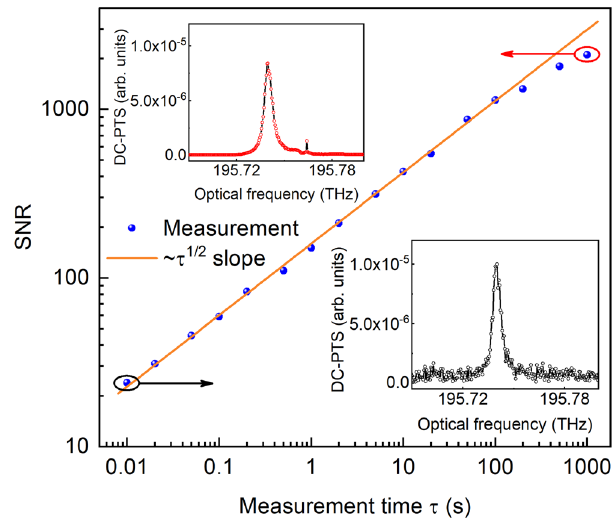
Fig. 7 Variation of the SNR of 2% C 2 H 2 with the measurement time. The measurement SNR is de fi ned as the ratio of the peak magnitude of the PTS response to the standard deviation of noise in the non-absorption range. Insets: typical DC-PTS spectra measured at 10 ms and 1000 s,